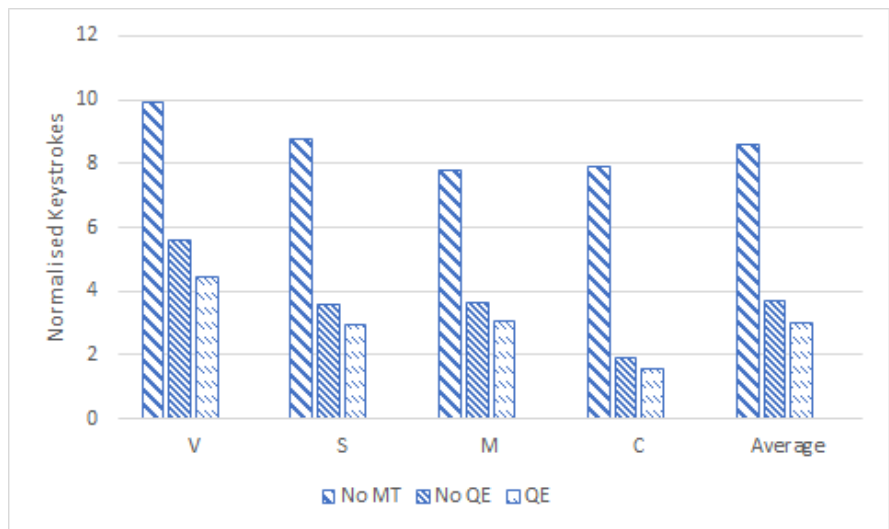
Figure 4. Normalised keystrokes spent